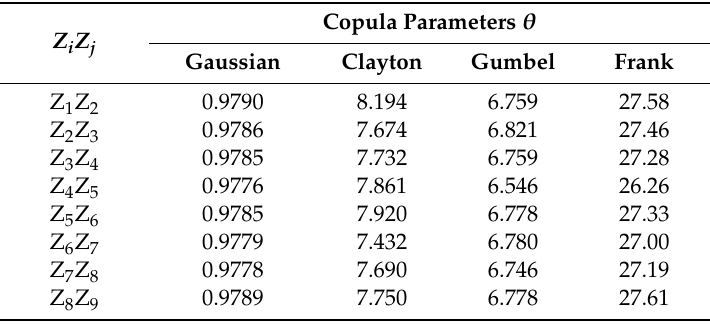
Table 8. The copula parameters for the candidate copulas.